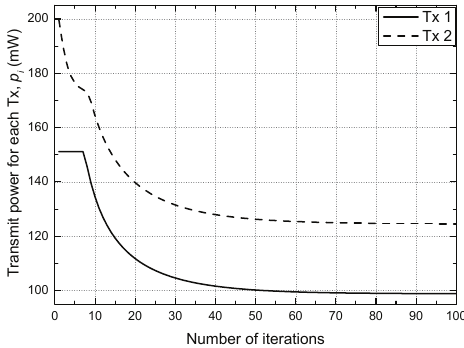
Figure 2. Convergence of the proposed